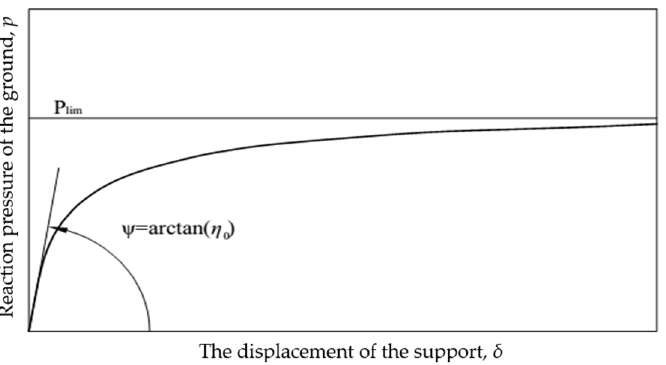
Figure 3. Relationship between the reaction pressure p caused by the surrounding soil and the tunnel lining deformation δ .